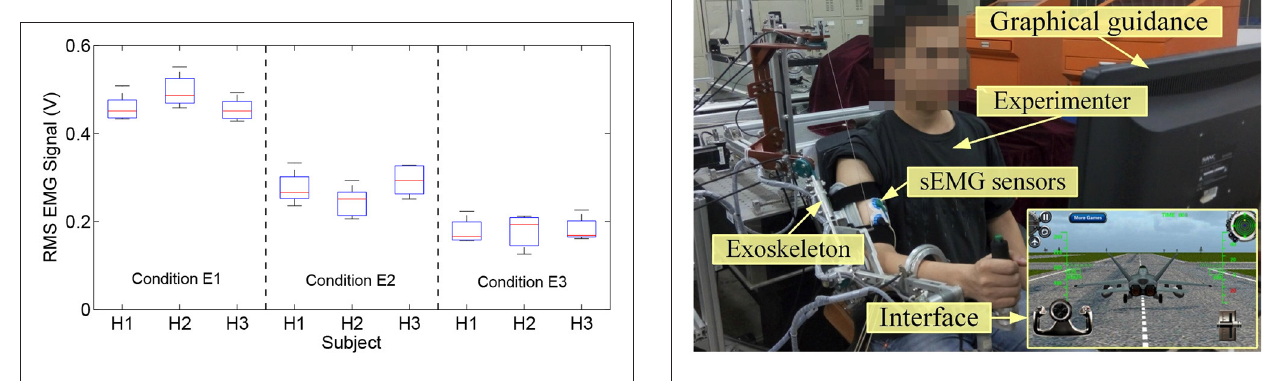
TABLE 2 | Comparison of statistical results of RMS EMG values of bicipital muscle and brachioradialis muscle under different experimental conditions. Con